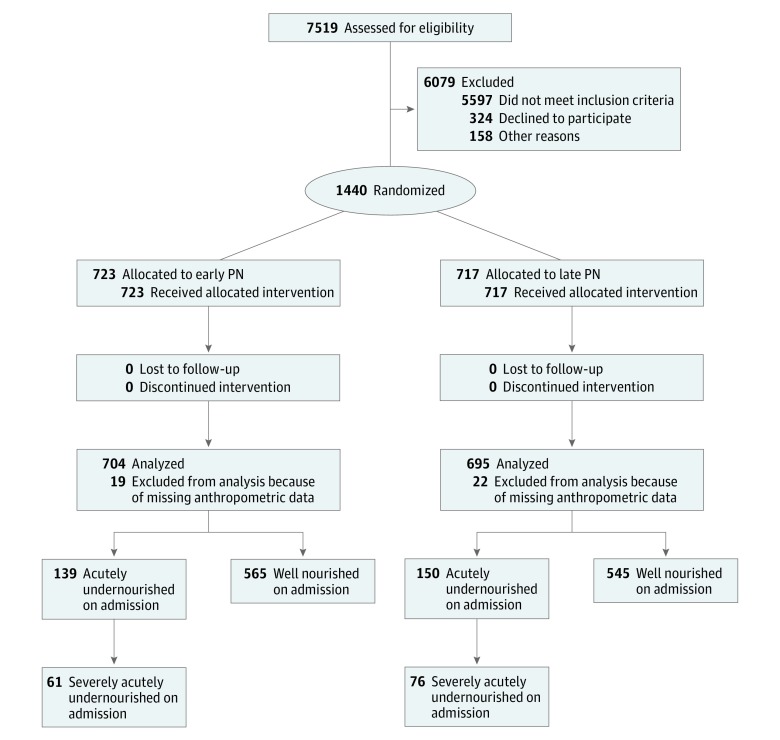
Flow Diagram of Children With and Without Undernourishment on Pediatric Intensive Care Unit AdmissionAcutely undernourished is defined as weight-for-age z score less than −2 (aged <1 year) or body mass index–for-age z score less than −2 (if aged ≥1).18,19 Severely acutely undernourished is defined as weight-for-age z score less than −3 (<1 year) or body mass index–for-age z score less than −3 (if aged ≥1 year).18,19 PN indicates parenteral nutrition.